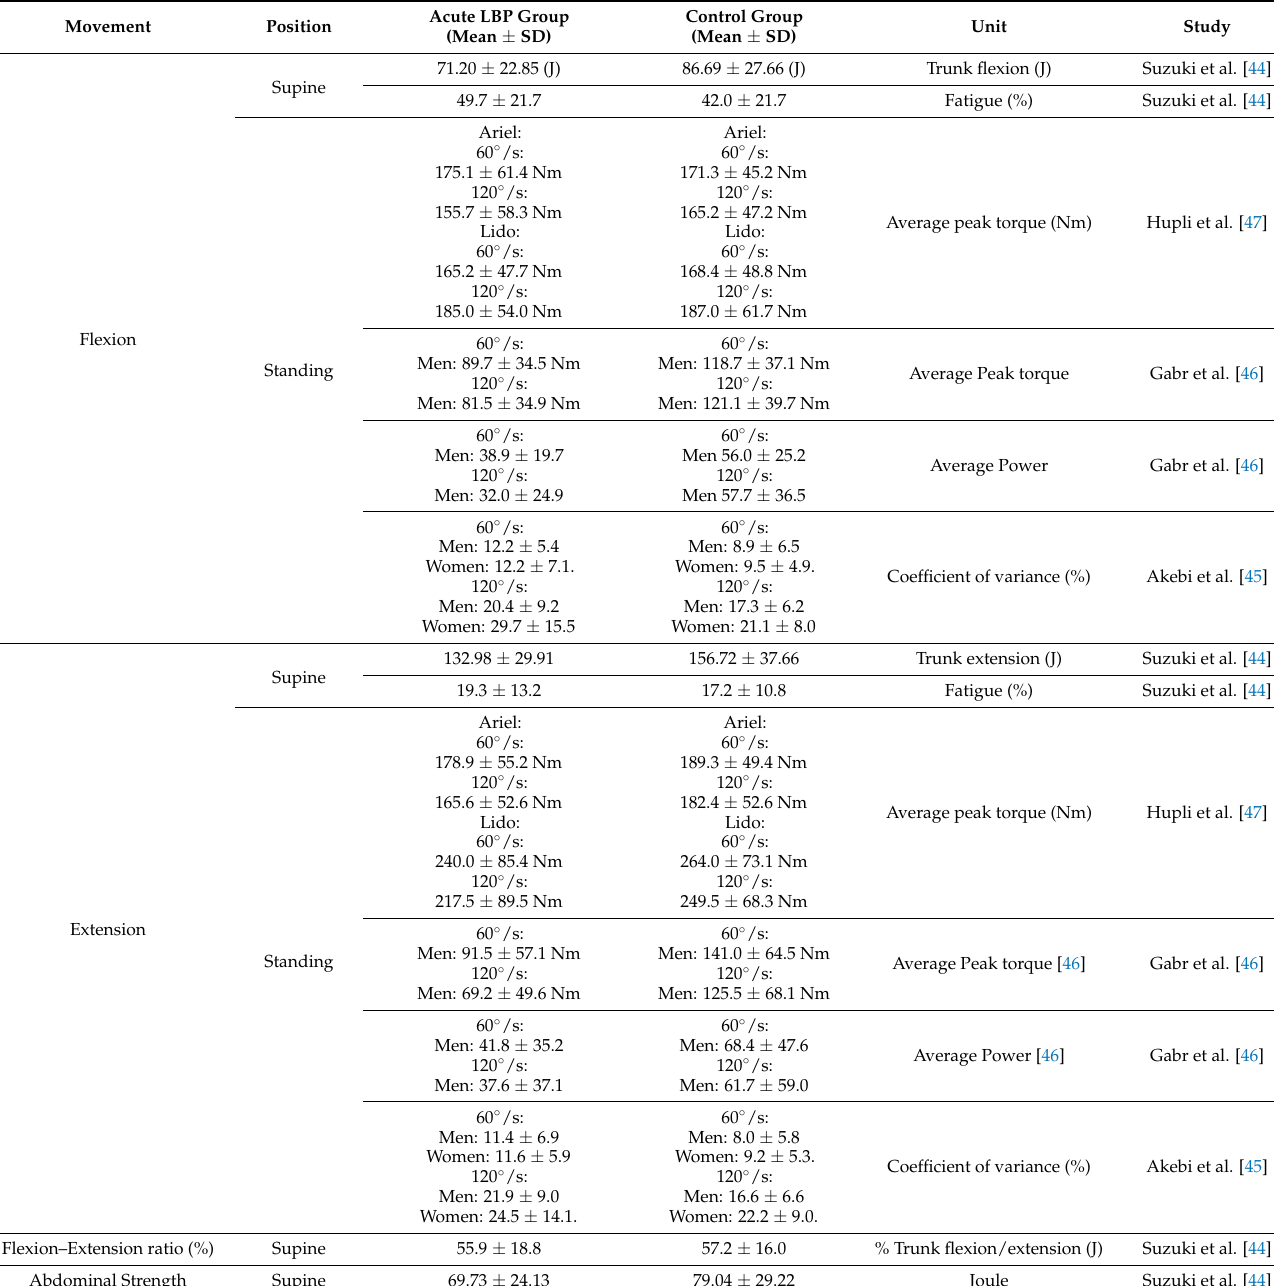
Table 3. Isokinetic trunk strength in acute low back pain patients (ALBP) and healthy adults for trunk extension and flexion. Movement Position Acute LBP Group (Mean ± SD) Control Group (Mean ± SD) Unit